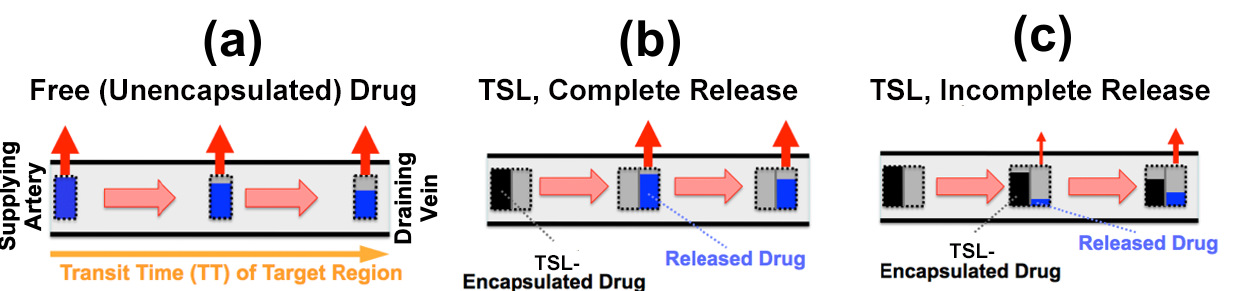
Figure 5. Microvascular concentration gradient. Plasma flows within a representative capillary between the supplying artery and draining vein of a tumor segment. Plasma concentration of unencapsulated/released drug (blue bar), and TSL-encapsulated drug (black bar) are shown, with red arrows indicating tumor drug uptake (i.e., drug extraction). Three cases are presented: ( a ) Unencapsulated drug infusion into supplying artery, ( b ) TSL with complete release during transit, and c ) TSL with incomplete release during transit. In ( b , c ), drug is first released from TSL, followed by tissue uptake. Note that all figures show first pass where no drug is yet present in the tissue interstitium. Figure reproduced from [20] (published under CC BY 4.0